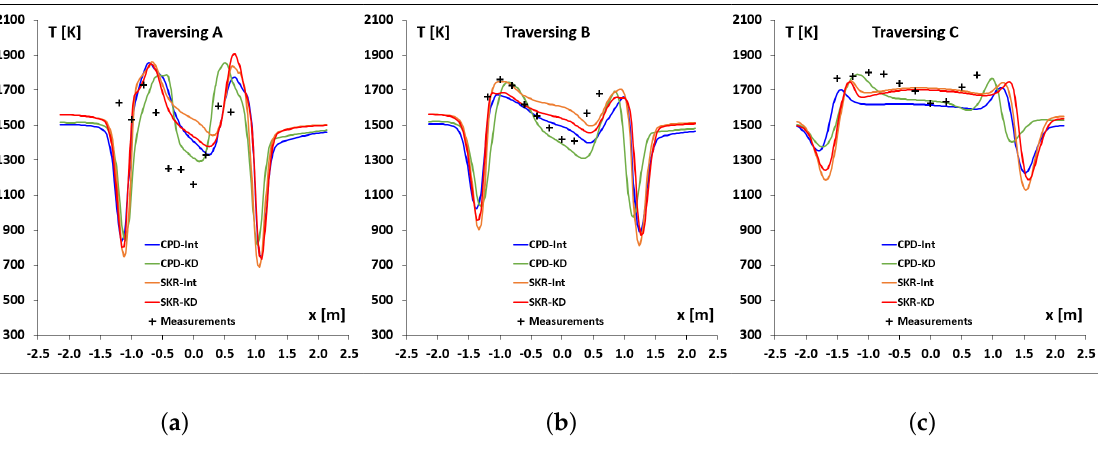
Figure 13. Temperature distribution along Traverses A ( a ), B ( b ) and C ( c